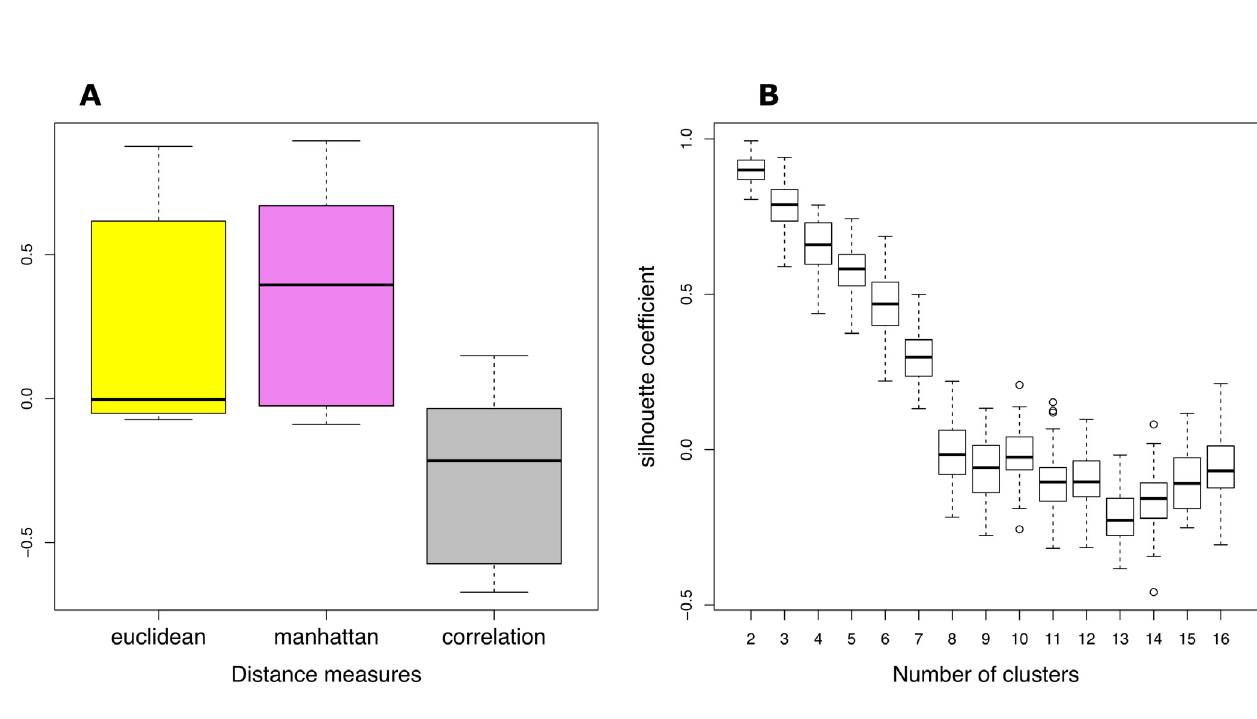
PLOS ONE | https://doi.org/10.1371/journal.pone.0226190 December31, 2019 22 /